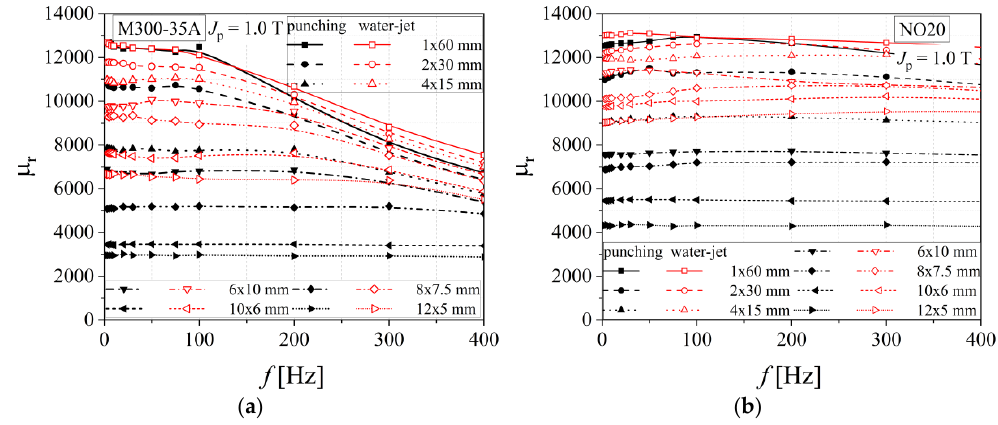
M400-65A ( a ) and M400-50A ( b ), in the case of two cutting technologies. Materials 2020 , 13 , x FOR PEER REVIEW